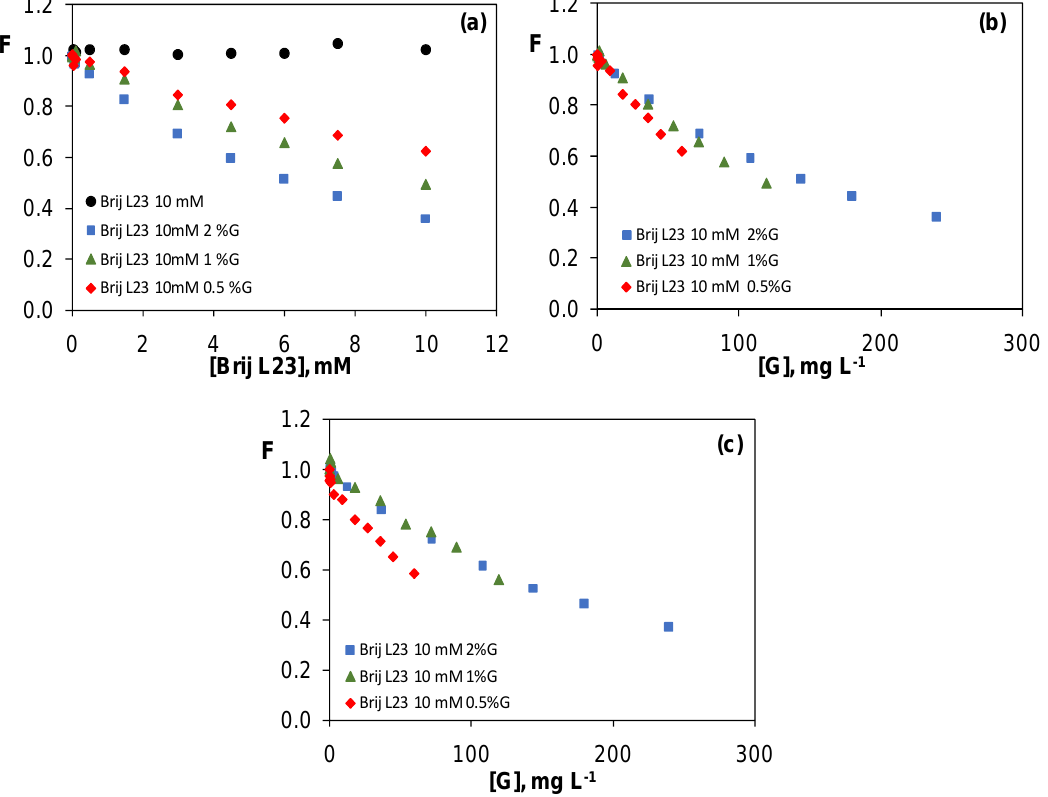
Figure 5. Change in the fluorescence of pyridoxine ( λ exc = 325 nm; λ em = 395 nm) in the presence of G dispersions in 10 mM Brij L23 vs. surfactant ( a ) and graphene ( b , c ) concentration for solutions with a constant w G /w S ( a , b ) or a constant Brij L23 concentration ( c ).